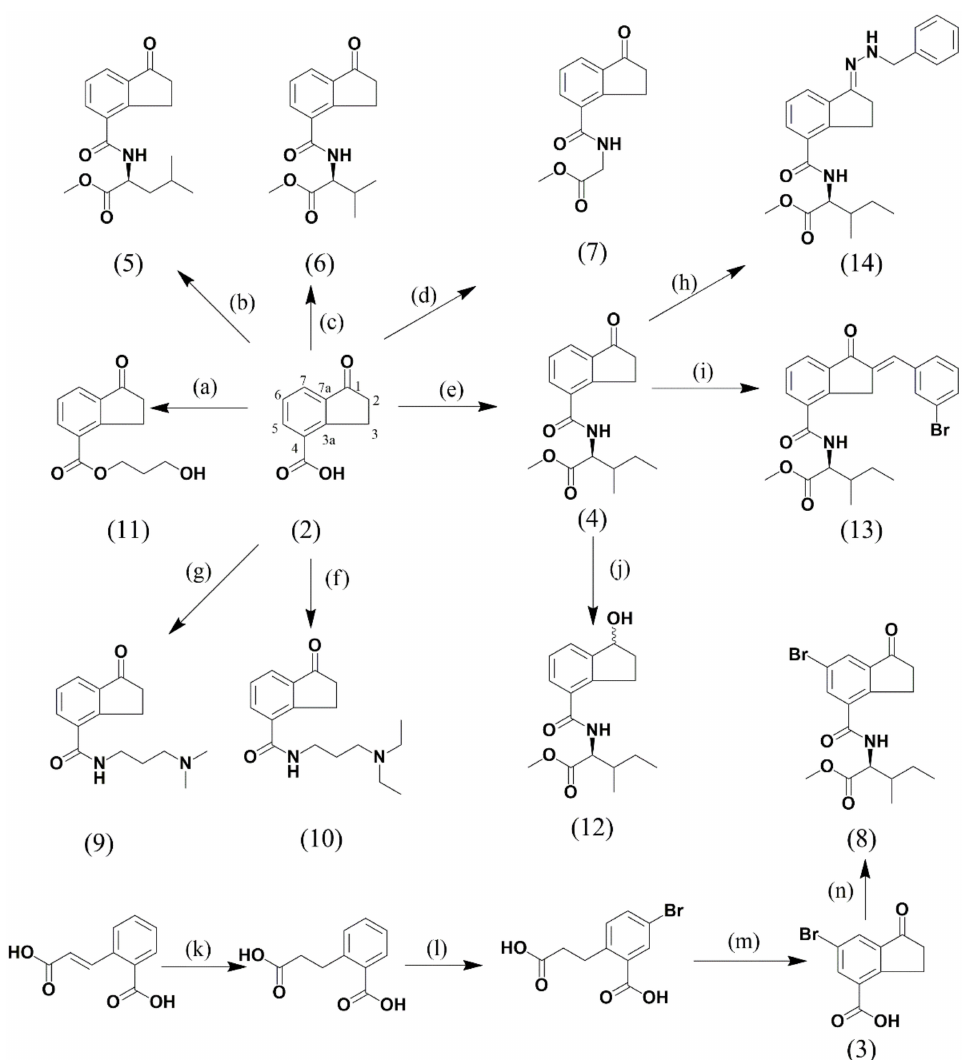
Figure 3. Synthesis and structures of the synthesized indanoyl derivatives. ( a )